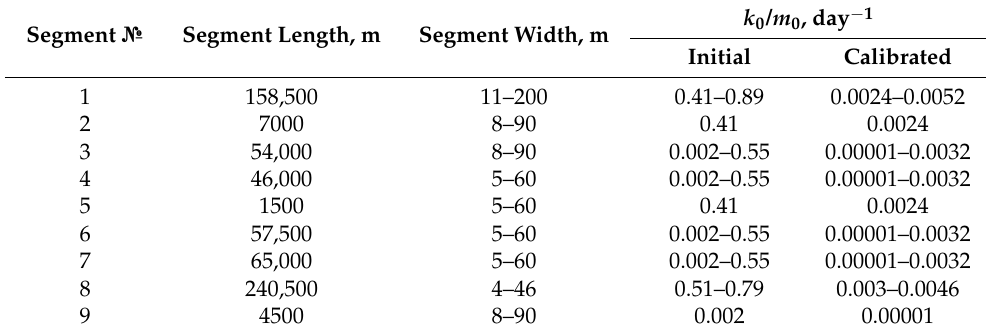
Figure 6. Time series of river runoff at the Langxinshan hydrological station and simulated river water leakage during the period 2000–2017. Table 1. Parameters of the river channel segments (the division of the channels into segments is presented in Figure